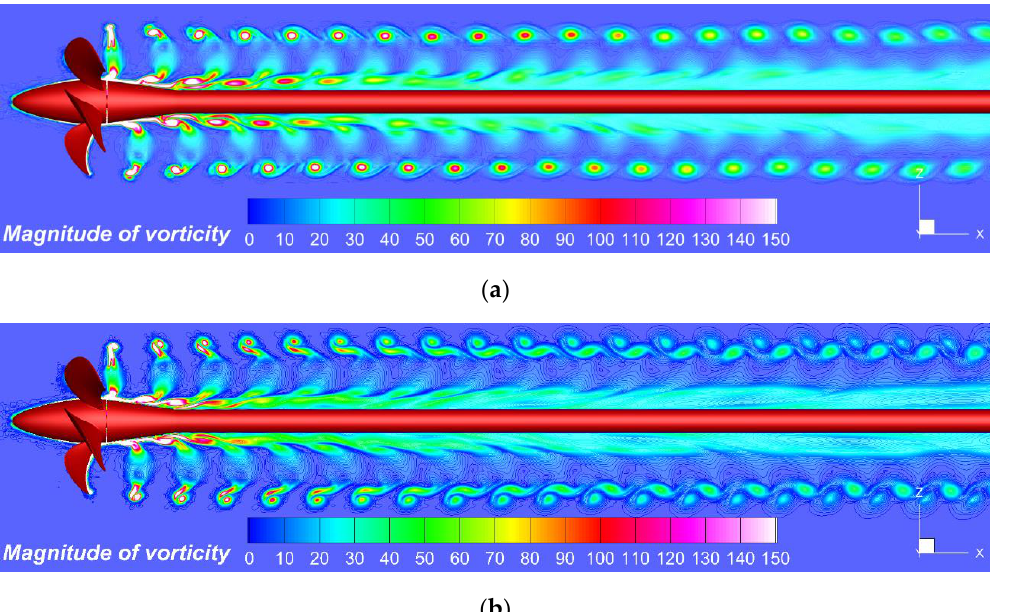
Figure 8. Streamwise vorticity field computed in the longitudinal plane of symmetry. ( a ): 𝐽 = 0.6418 ; ( b ): 𝐽 = 1.602 .